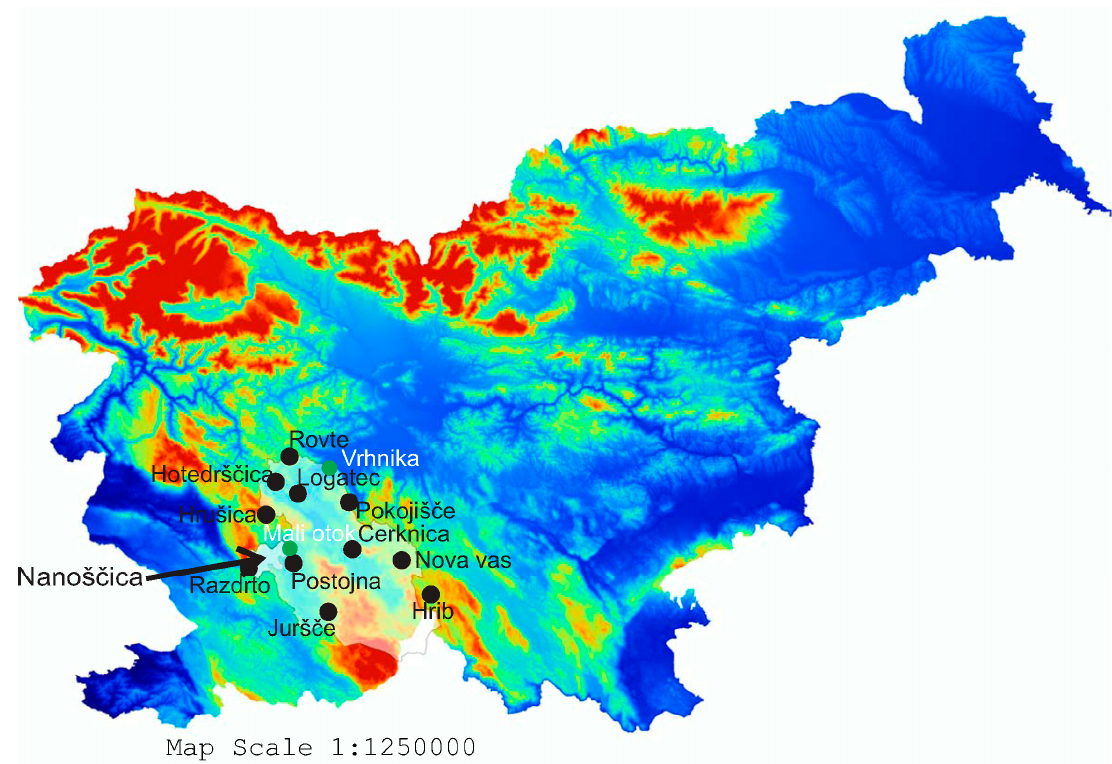
Figure 1. Location of the Ljubljanica River (Vrhnika station; green circle) and Nanoš č ica River (Mali otok station; green circle) catchments on a map of Slovenia and locations of the rainfall gauging stations (black circles) used. Table 1. Basic characteristics of the selected case studies and basic characteristics of the discharge series (Q) that were used for the model calibration.